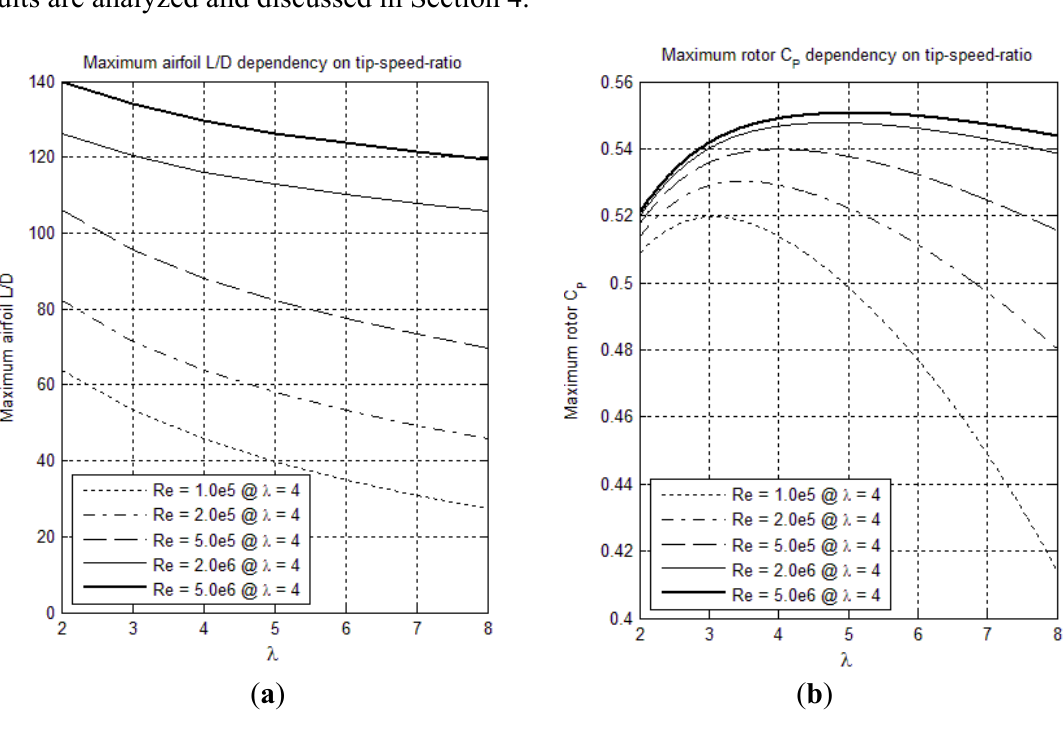
Figure 6. ( a ) Impact on L / D when TSR is changed and airfoil Reynolds number is